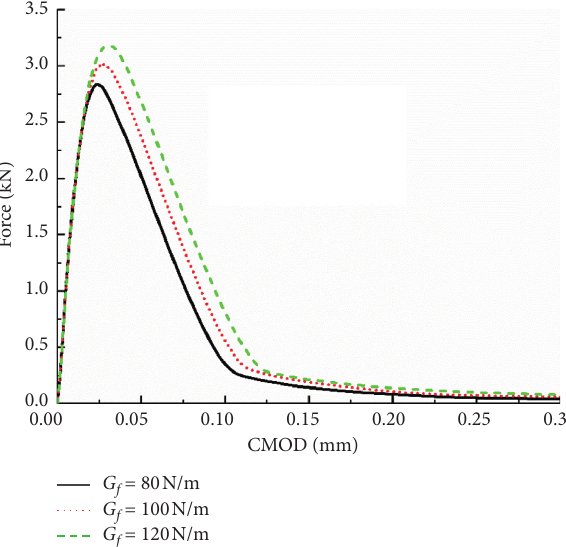
Figure 17: Effect of fracture energy on the P-CMOD